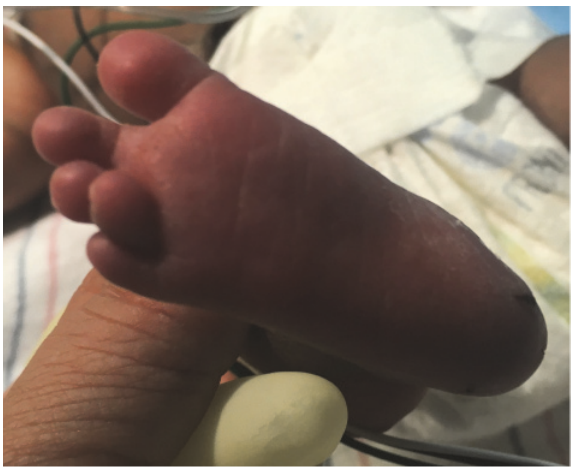
Figure 5: Photo showed overlapping of the third and fourth